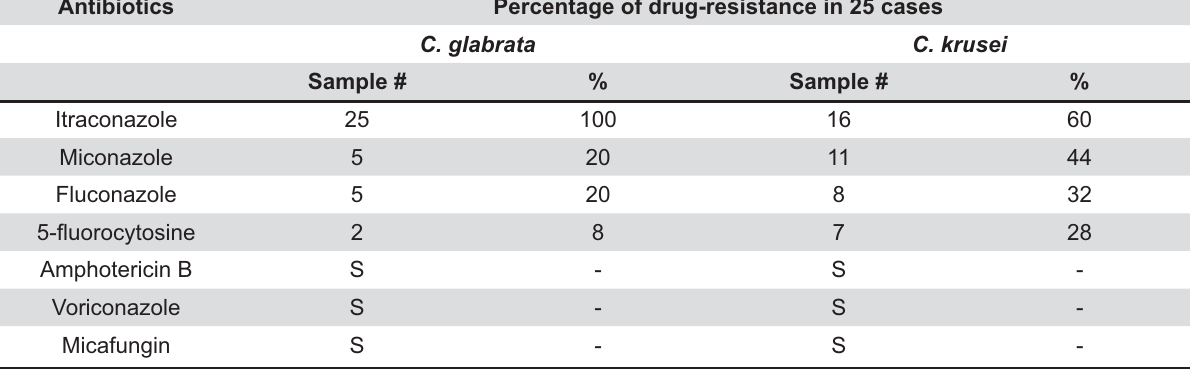
Table 3- Prevalence of Candida species against respective antibiotics